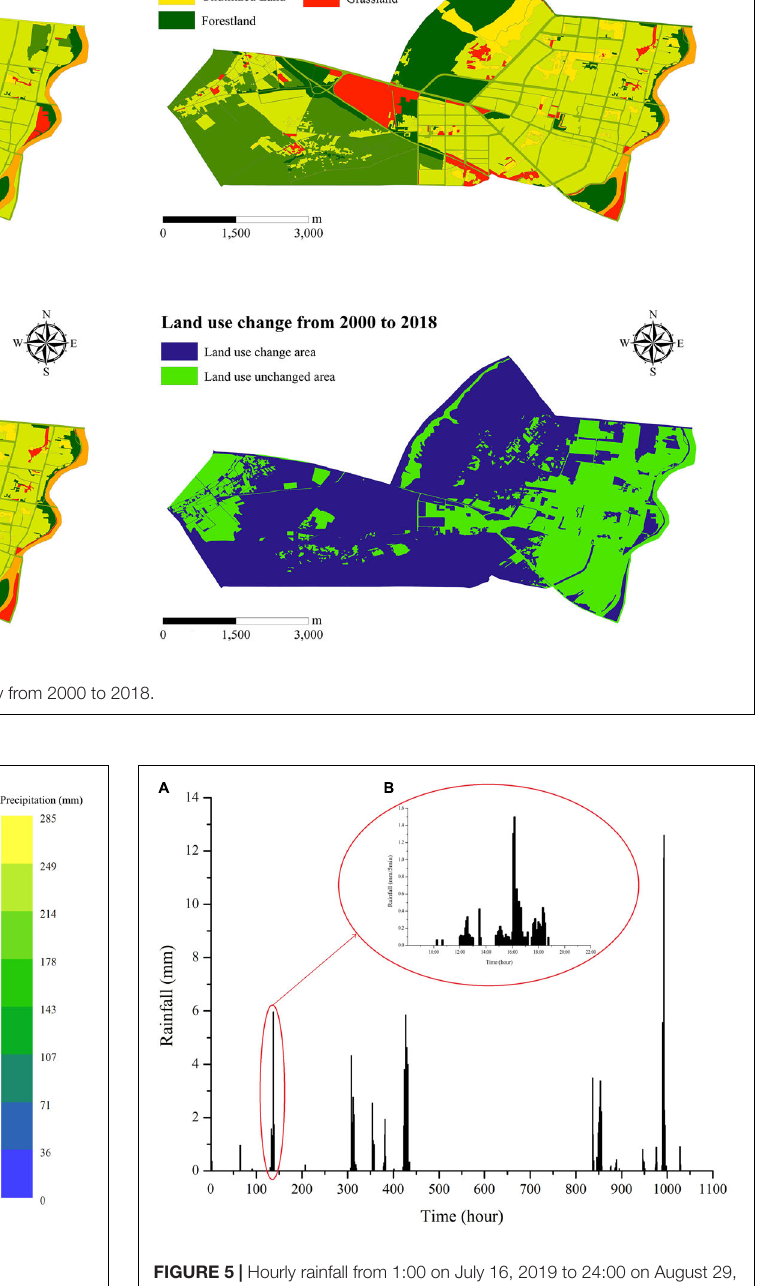
The land use change area accounts for 63.68% of the total area, mainly in the central and northern regions from 2000 to 2018 ( Figure 3D ).